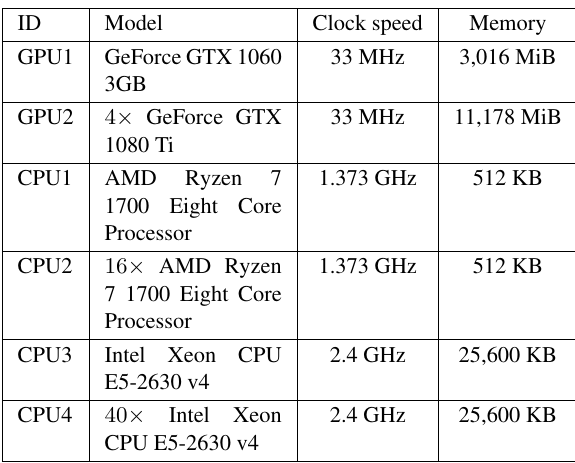
Table 2. Used processing